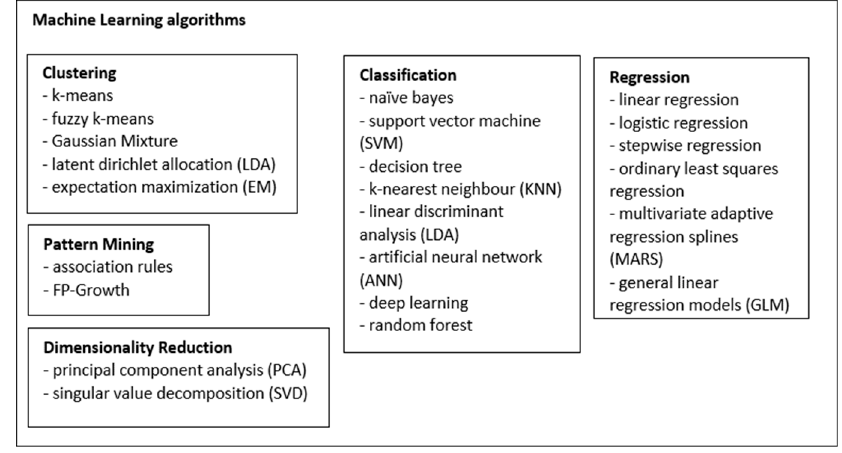
Figure 10. Some examples of machine learning algorithms.